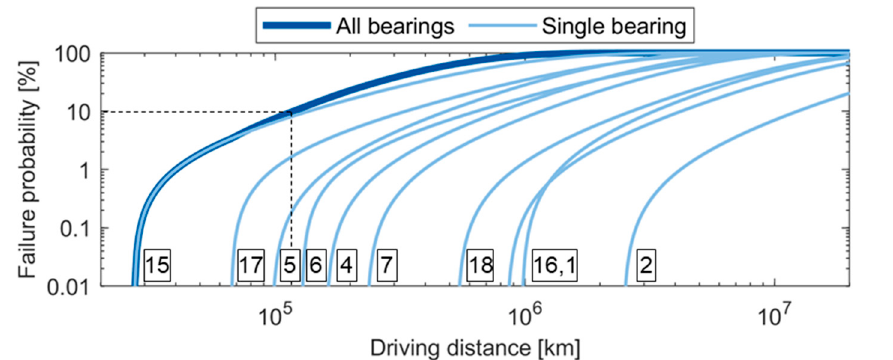
Figure 11. Failure probabilities of the individual bearings and the bearings as a group for the hybrid drivetrain. The position numbers of the bearings are shown framed (see Figure 2). The dotted line indicates the B 10 -lifetime of the bearing group with 123,000 km.